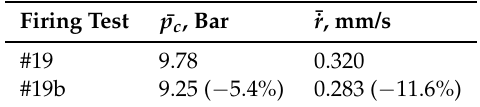
Figure 6. Effect of the activation energy on the fuel regression rate and the fuel temperature: ( a ) fuel regression rate; ( b ) fuel temperature. Table 8. Computed average results for Firing Test #19 with the effect of a change in the activation energy, Case